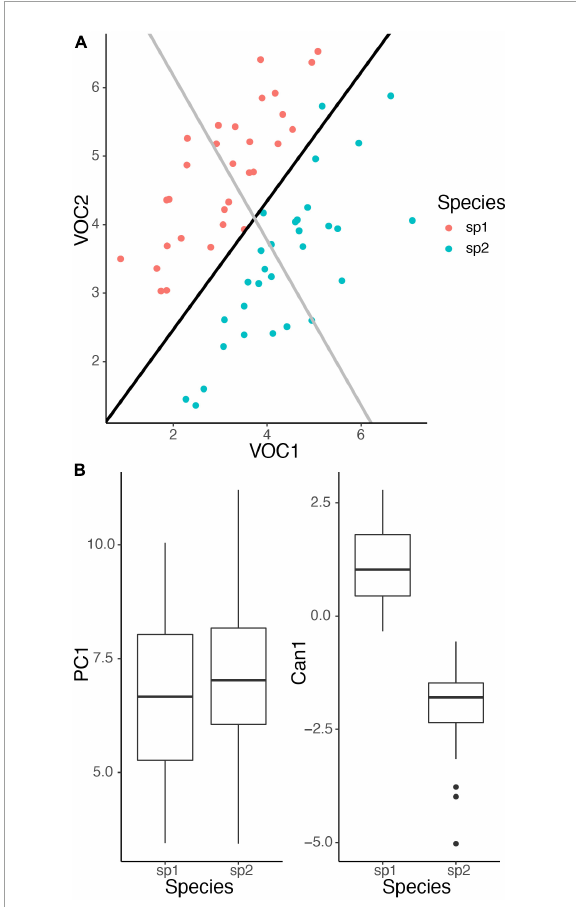
FIGURE2 Illustration of unconstrained ordination vs. constrained ordination. Species 1 (sp1) has lower average emissions of VOC 1 (mean = 3) and higher average emissions of VOC 2 (mean = 4.5) than species 2 (sp2) (means = 4.5 and 3.5). Within both species emissions of the two volatiles follow a multivariate normal distribution with covariance between the volatiles equal to 0.75. (A) Unconstrained ordination with principal components analysis (black line) reflects total emissions, whereas constrained ordination with canonical discriminant analysis (CDA) (gray line) correctly captures the difference between the species. (B) Boxplots for ordination scores. Projecting the points onto the two axes shows that only CDA separates the two species well. All analyses performed in